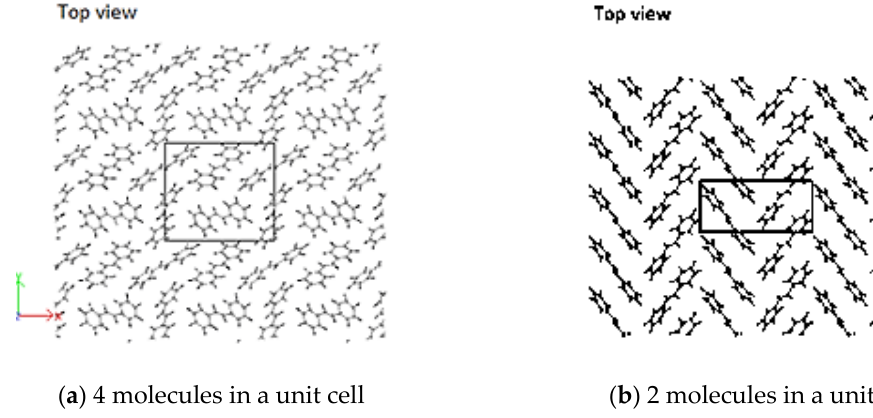
Figure 10. ( a ) Stilbene using unit cell by [55]; ( b ) herringbone- (HB)-packing of 2PPV (stilbene) from simulation using 2 molecules.